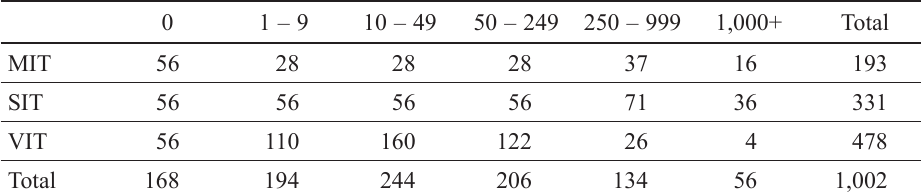
Table 4. Structure of the observed sample, 2006